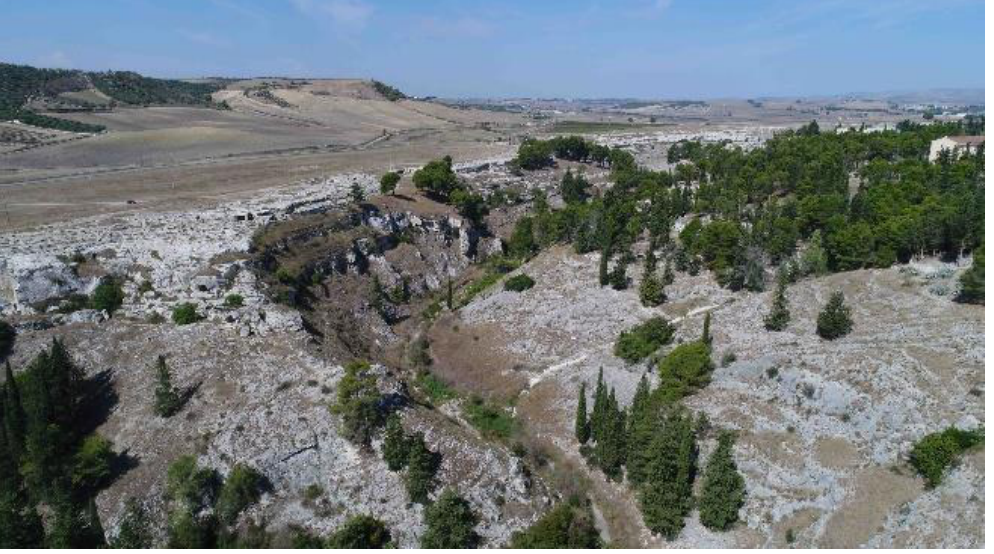
Figure 3. Topographic characteristics of the site in proximity of the Gravina torrent.